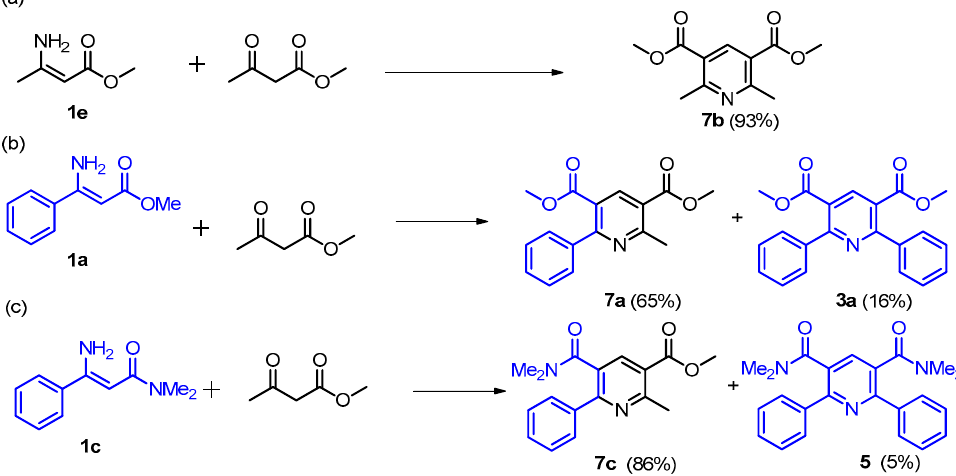
Scheme 5. Cross coupling of β -enamine carbonyls with β -keto carbonyls. ( a ) Reaction of 1e with acetoacetate, ( b ) reaction of 1a with acetoacetate, ( c ) reaction of 1c with acetoacetate.